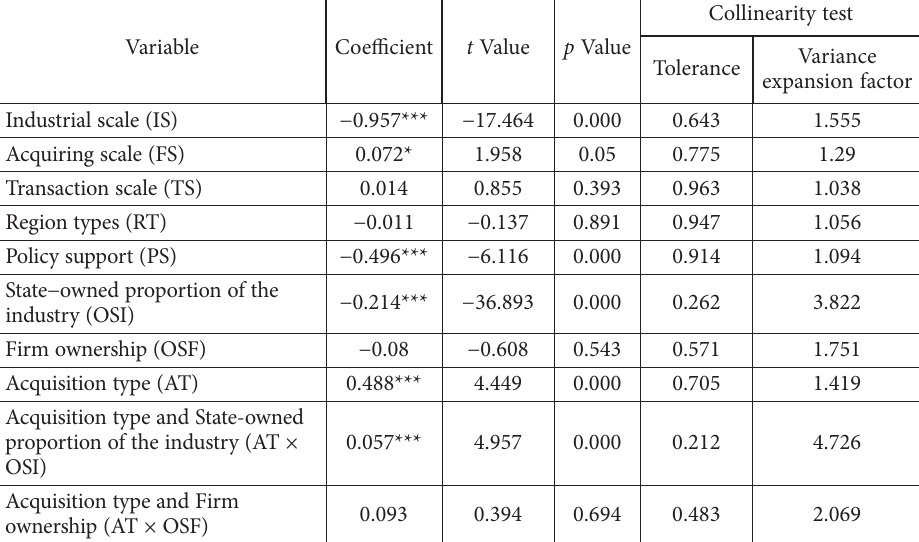
Table 7. The moderating effect of industrial state-owned proportion and firm